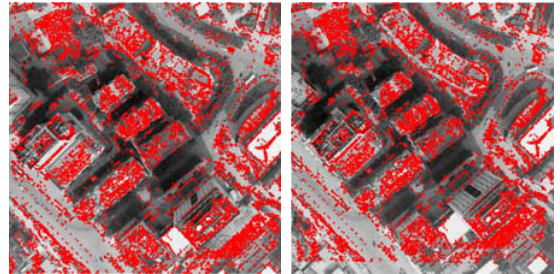
Figure 7. Corresponding points are obtained by plane-sweeping matching method